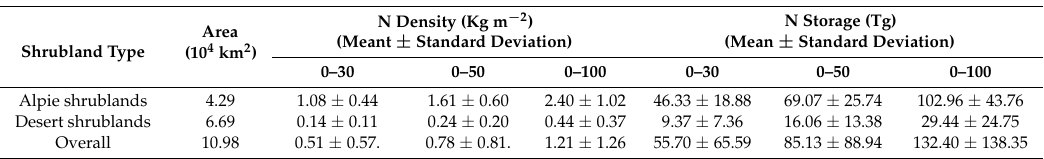
Table 1. Mean and standard deviation of soil N density and storage at depths of 0–30, 0–50 and 0–100 cm in shrublands on the Tibetan